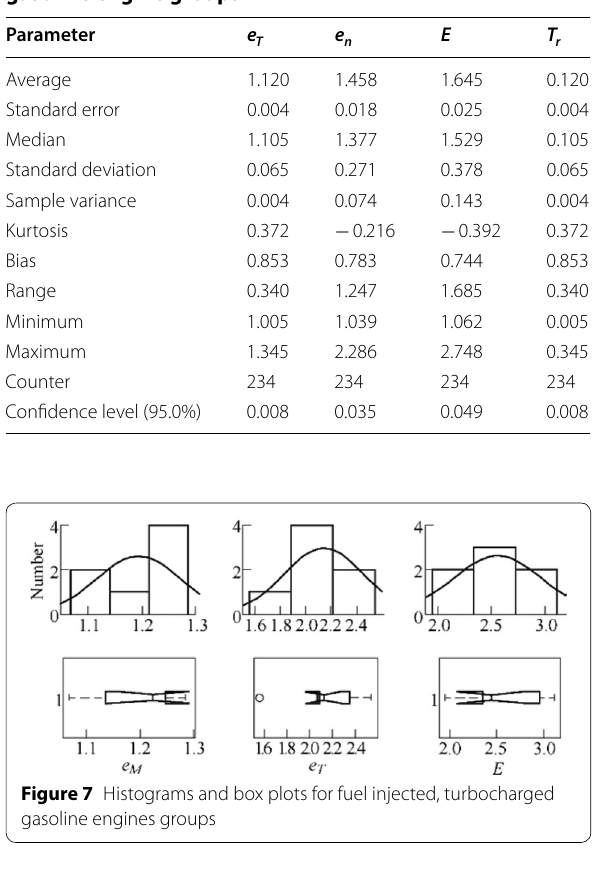
Table 6 Results of the calculations for fuel injected